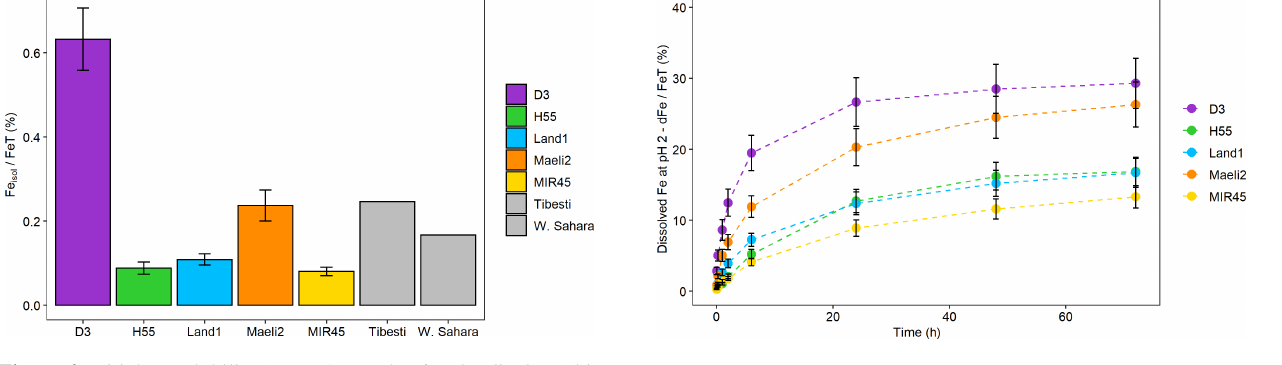
Figure 5. Fe dissolution kinetics at pH 2. The data uncertainty was estimated using the error propagation